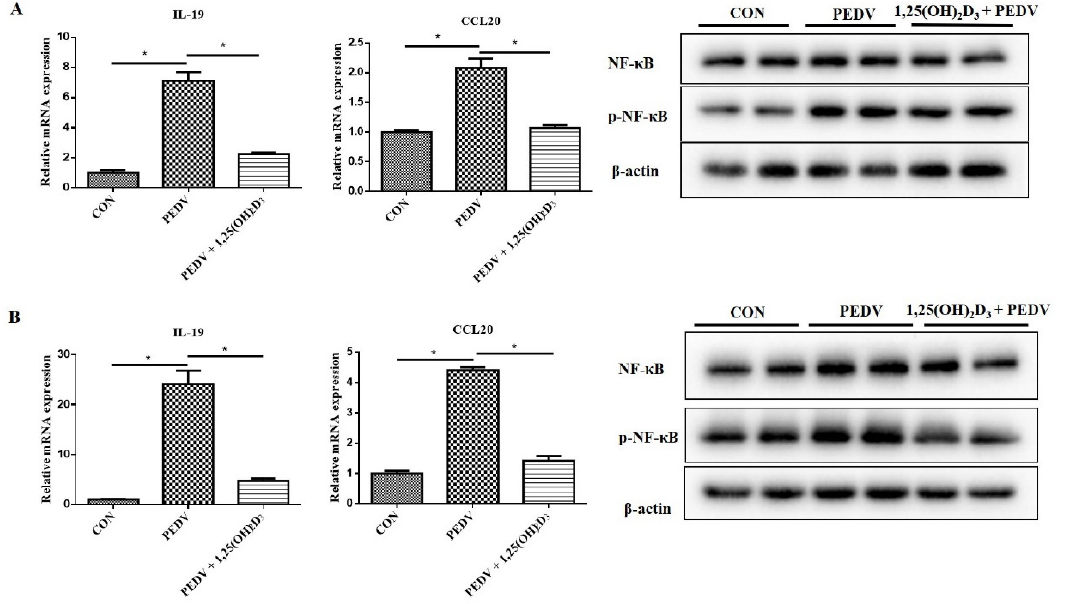
Figure 3. Effects of 1,25(OH) 2 D 3 on inflammatory cytokine expression in PEDV-infected IPEC-J2 cells ( A ) and 3D4/21 cells ( B ) at 24 h post-infection. Sub-confluent cells were incubated with 1,25(OH) 2 D 3 (20 nM) for 24 h, after which the cells were infected with PEDV (1 MOI). After 1 h of absorption, the cells were washed with PBS and cultured with 1,25(OH) 2 D 3 (20 nM) for further 24 h. Then, the cells were collected for RT-qPCR and Western blotting analysis. * p <